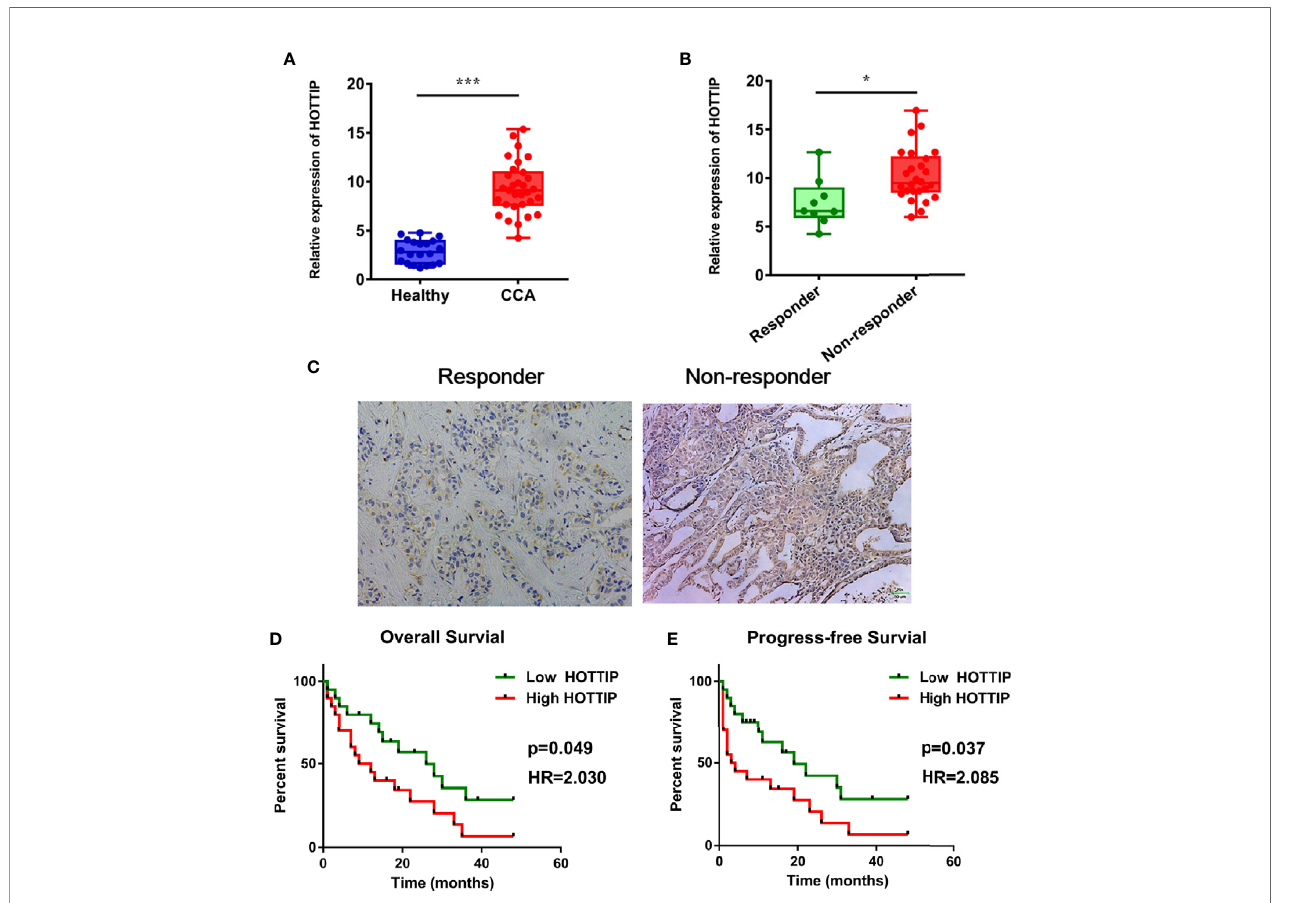
FIGURE 1 | Upregulation of HOTTIP in CCA patients. (A) The serum HOTTIP expression levels of healthy volunteers and CCA patients. (B) The serum HOTTIP expression level CR+PR versus SD+PD patients before treatment. (C) In situ hybridization (ISH) staining of HOTTIP. Representative high and low HOTTIP expression images are shown. Overall survival (D) and disease-free survival (E) of high and low HOTTIP expression patients were analyzed by Kaplan-Meier analysis. (*p < 0.05, ***p <